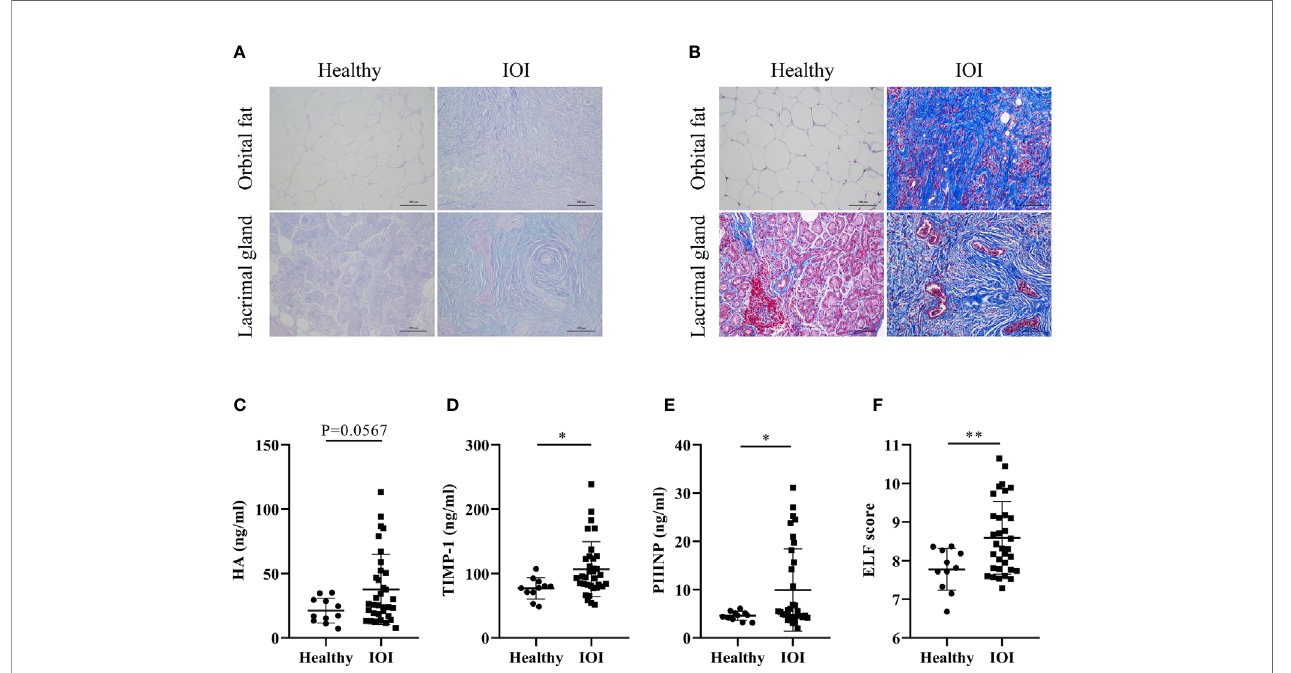
FIGURE 5 | Degree of fi brosis in idiopathic orbital in fl ammation (IOI). (A) Immunohistochemical staining of hyaluronic acid (HA) (Alcian blue/periodic acid-Schiff (AB- PAS) staining, magni fi cation ×200) and (B) collagen (Masson staining, magni fi cation ×200). Concentrations of plasma HA (C) , matrix metalloproteinase-1 (TIMP-1) (D) and amino-terminal propeptide of procollagen type III (PIIINP) (E) . (F) Enhanced liver fi brosis (ELF) scores of patients with IOI (n = 33) and healthy controls (n = 11). * P < 0.05; ** P <